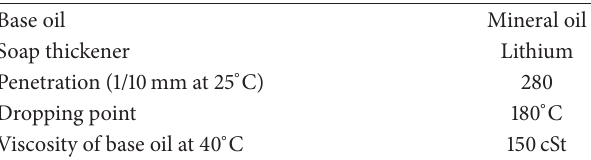
Table 1: Composition of the tested grease.